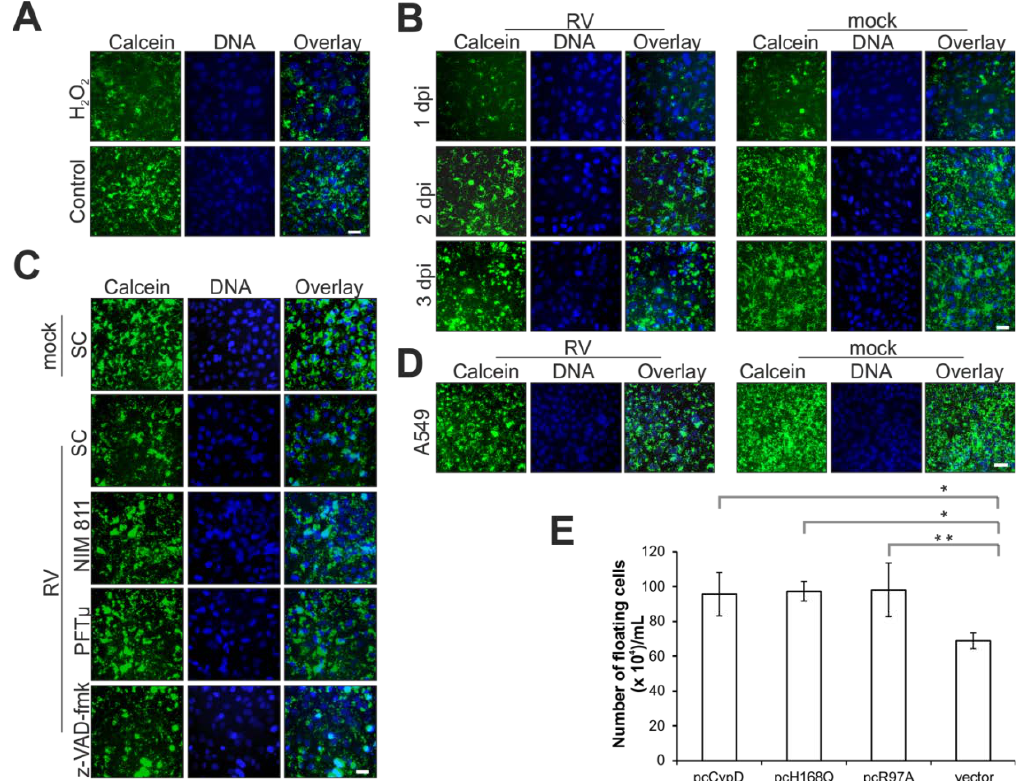
Figure 2. Effect of RV replication (in the presence and absence of indicated pharmacological inhibitors) on the mPTP. ( A ), ( B ), ( C ), ( D ) mPTP opening was assessed through application of calcein-AM. Cytosolic calcein was quenched with CoCl 2 . Calcein signal is shown in green, nuclear DNA in blue, cyan colour results from the overlay of both imgaes. ( A ) mPTP opening was induced by overnight incubation of Vero cells with 0.003% H 2 O 2 ; ( B ) Time course analysis (1, 2, 3 dpi) of mPTP opening under RV infection; ( C ) Three days after infection with RV, the effect of the pharmacological inhibitors NIM811 (2 μM) at 2 hpi, z-VAD-fmk and PFTμ (both at 12.5 μM) at 24 hpi on the mPTP opening was assessed in comparison to the SC; ( D ) Analysis of mPTP opening in RV- and mock-infected A549 cells at 3 dpi; ( E ) RV-infected Vero cells were transfected at 2 hpi with plasmids encoding native CypD protein and mutants of the PPIase domain (H168Q and R97A). Number of floaters was determined at 3 dpi in comparison to the vector control (pcDNA3). SC, solvent control; scale bar, 20 μm. * p < 0.05, ** p < 0.01, *** p < 0.001, **** p < 0.0001.